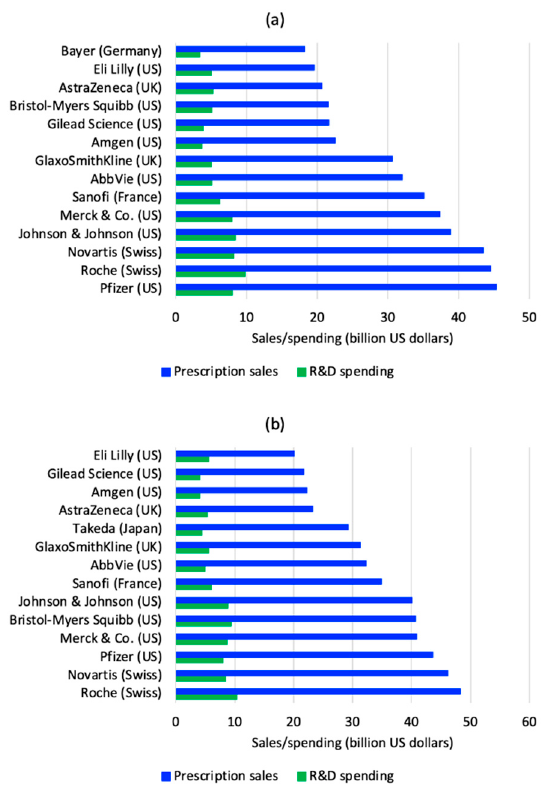
Figure 3. Top global pharmaceutical companies by sales and R&D spending in 2018 ( a ); and 2019 ( b ) [83].